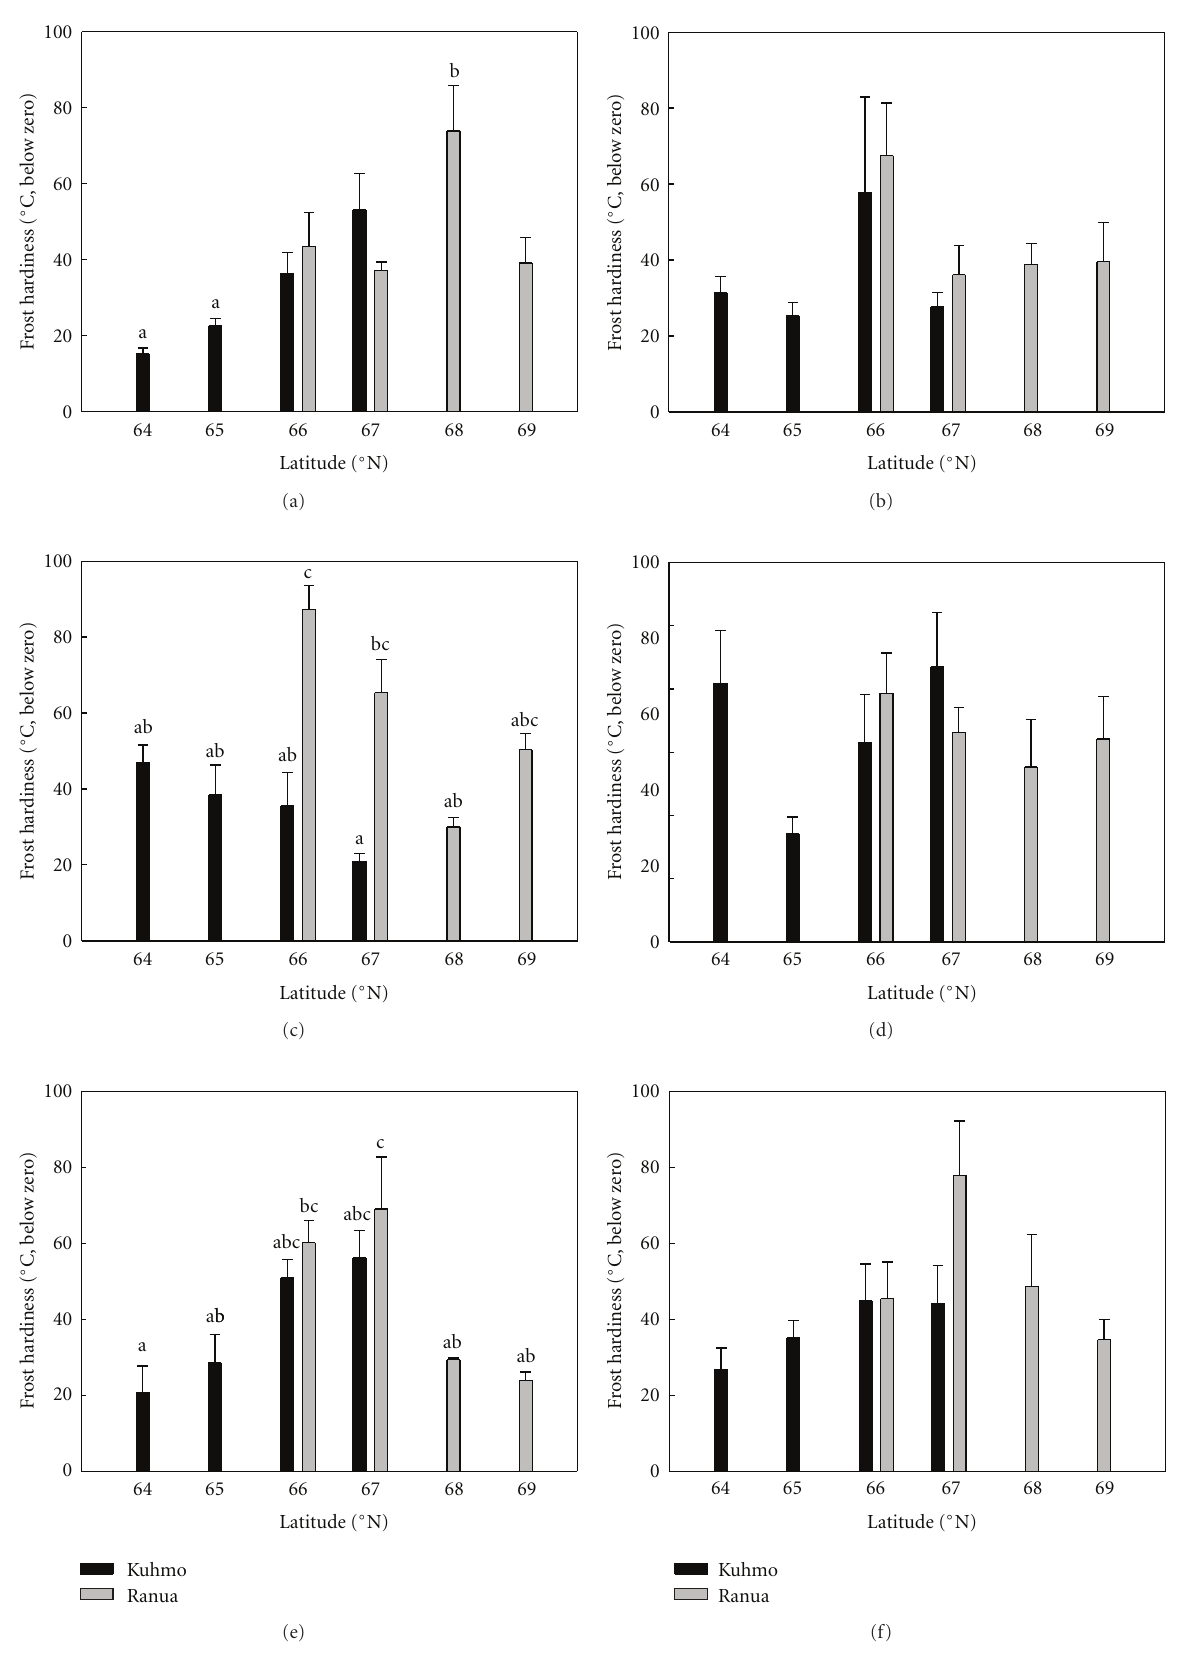
Figure 6: Frost hardiness (mean ± SE, n = 6–8), text otherwise as in Figure